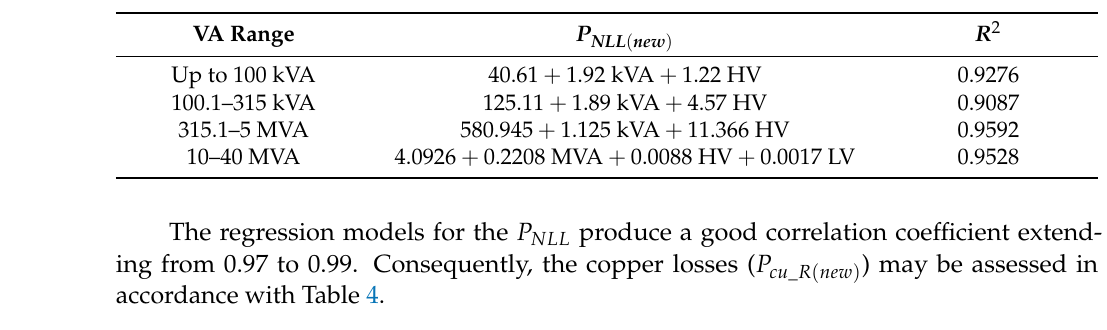
Table 3. Proposed regression models for P NLL ( new ) .